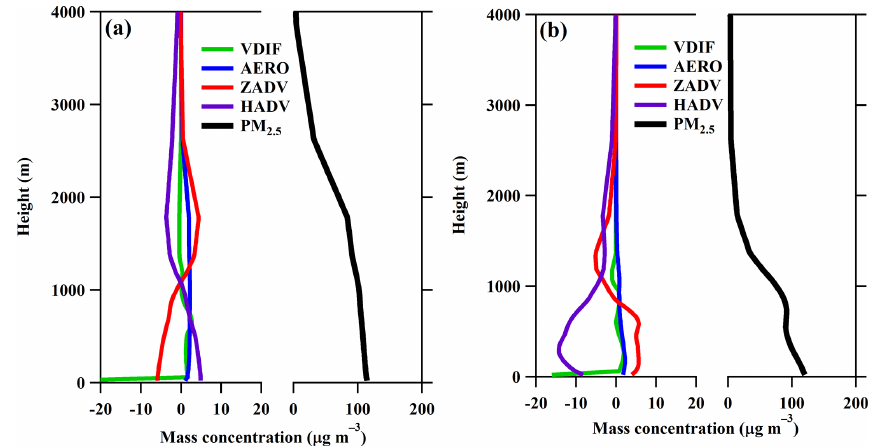
Figure 7. Vertical profiles of PM 2 . 5 concentrations and the contributions of physical/chemical processes over the centre of the YRD (from 30 to 33 ◦ N) to PM 2 . 5 concentrations (a) at the beginning and (b) at the end of the cold frontal